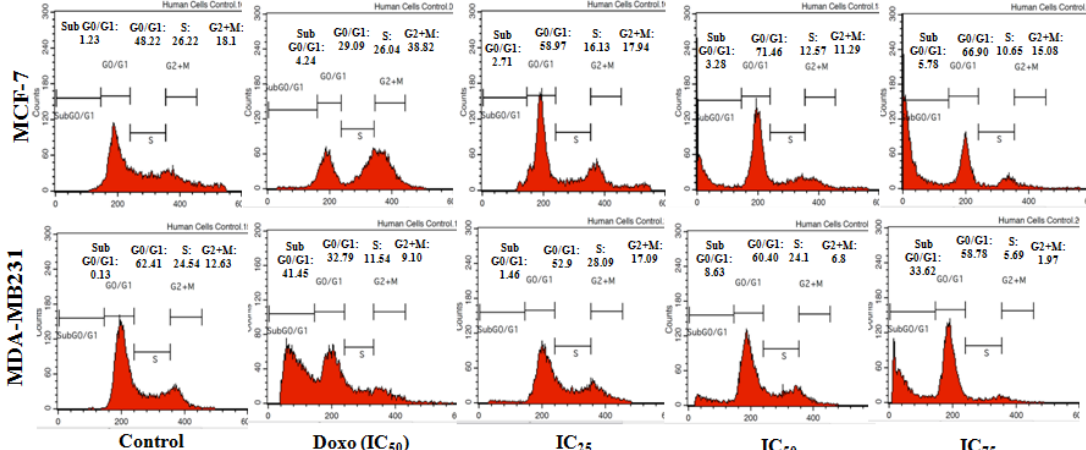
Figure 3. Cell cycle distribution of MCF-7 and MDA-MB231 at 48 h post-treatment when treated with Doxorubicin (IC and IC IC 50 75